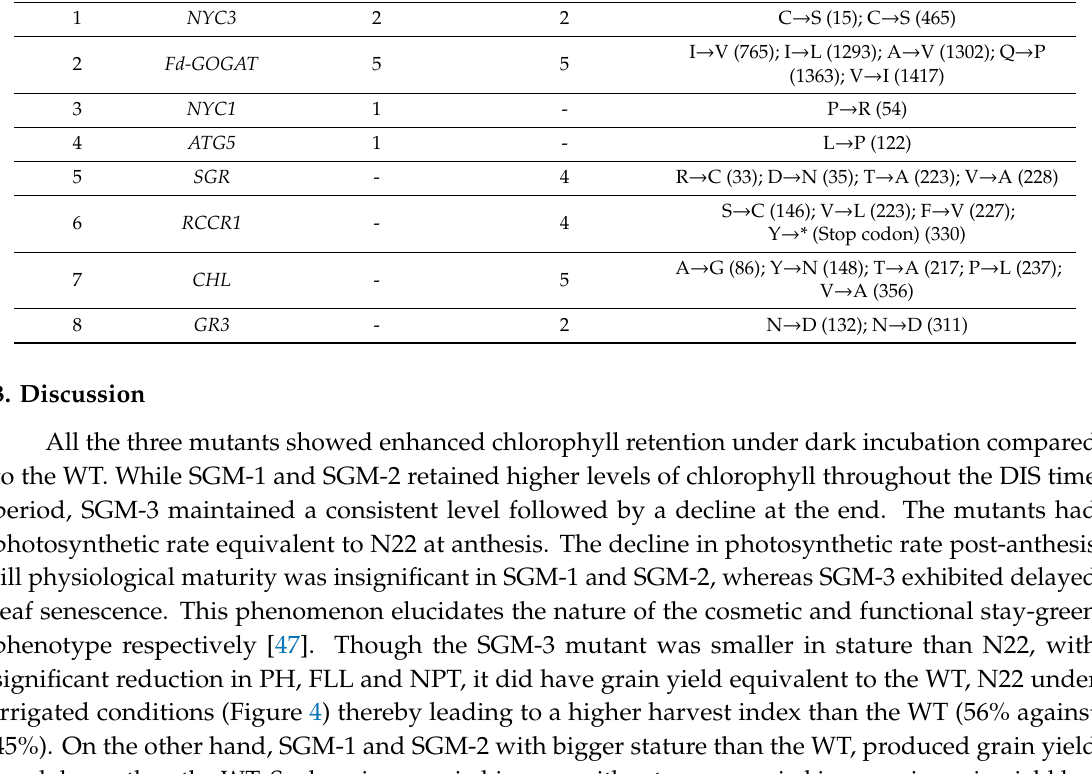
Table 1. Non-synonymous mutations observed in SGM-1 and SGM-2 in the eight of the 15 candidate genes. SGM-3 had no sequence variation in any of the 15 candidate genes. For more details refer to Table S4. No. of Non-Synonymous (NS) Details of NS Changes (Amino Acid Mutations S. No. Gene Name Positions and Changes from WT to